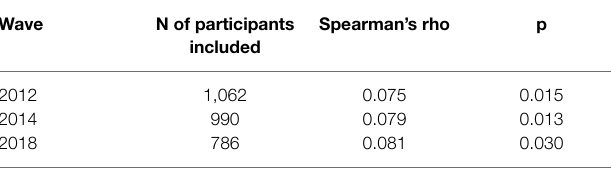
TABLE 4 | Rank correlation coefficient between plasma HOcy concentration ( μ mol/l) and FI at the three waves.